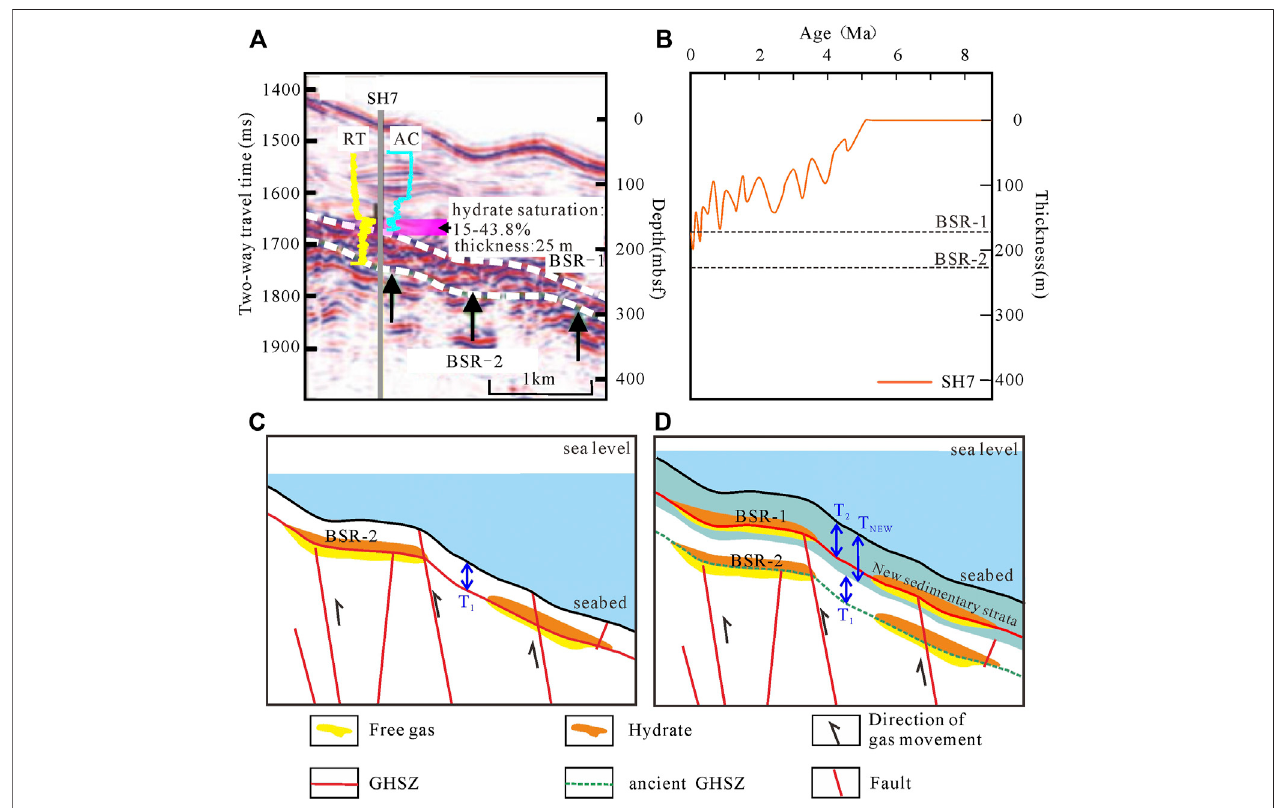
FIGURE6|(A) Seismicre fl ectioncharacteristicsofdoubleBSRsacrosssiteSH7(modi fi edfromSunetal.,2018). (B) ThethicknessevolutionprocessoftheGHSZ at W17 since 8.2 Ma (C),(D) Double BSRs pattern based on changes in formation temperature, pressure and other conditions (taking site SH7 as an example).